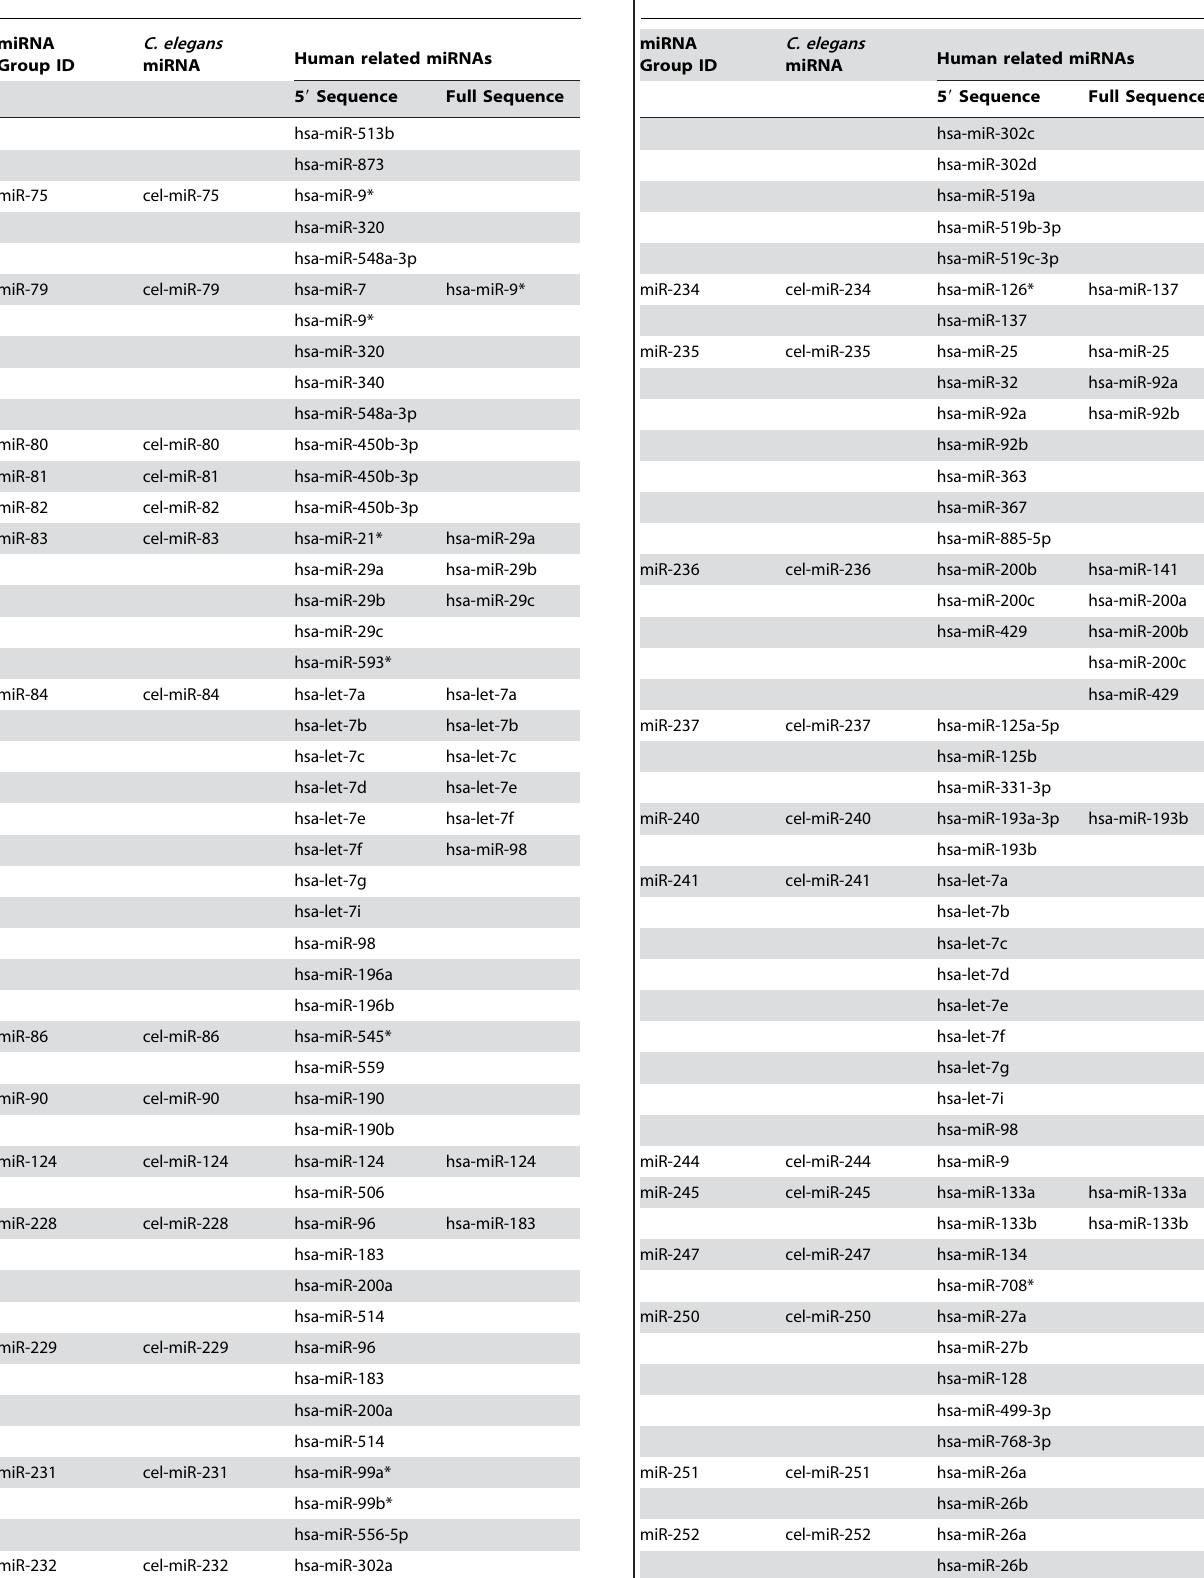
Table 4. cont. Table 4.